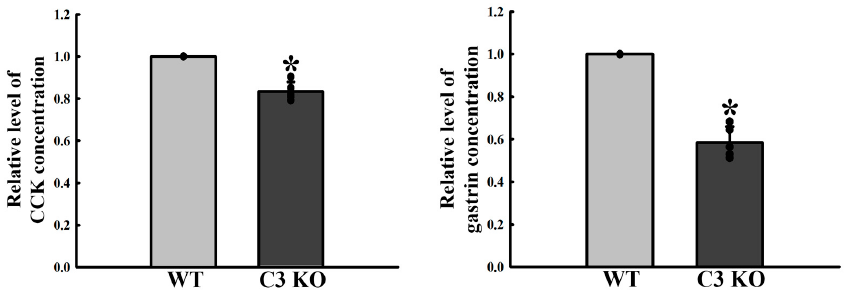
Figure 7. Concentrations of GI hormones. The concentrations of CCK and gastrin were measured in the mid colon homogenate using an enzyme-linked immunosorbent assay. The minimum detectable concentration of each kit was 0.1–1000 pg/mL of CCK and 0.312–20 pg/mL of gastrin. Five mice per group were used to prepare tissue homogenate, and the hormone levels were assayed in duplicate for each sample. Data are reported as the mean ± SD. * p < 0.05 compared to the WT group. Abbreviations: WT, wildtype; KO, knockout; GI hormone, gastrointestinal hormone; CCK,